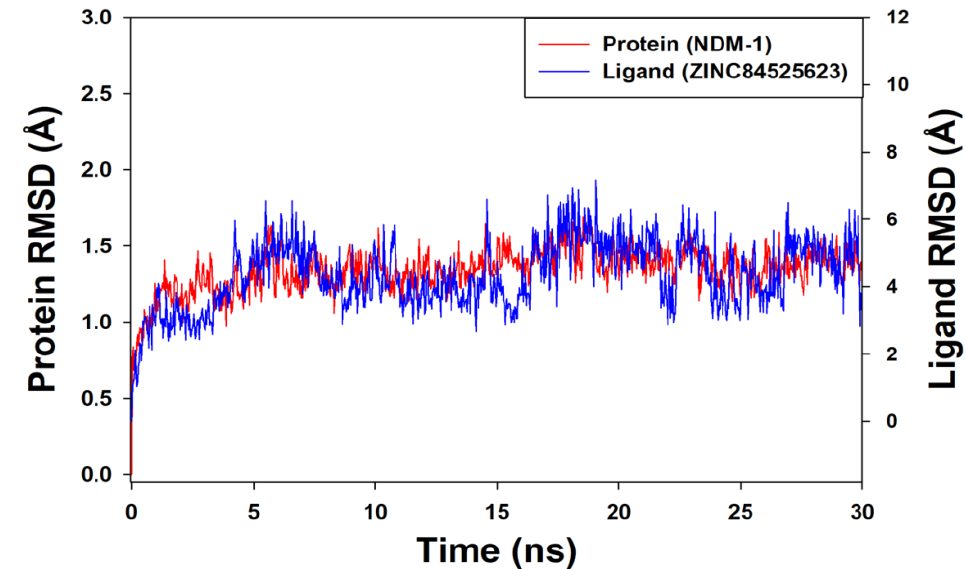
Figure 4. The molecular dynamic (MD) simulation of ZINC84525623 with NDM-1 depicting the root mean square deviations (RMSDs) of NDM-1 alone and the NDM-1-ZINC84525623 complex.